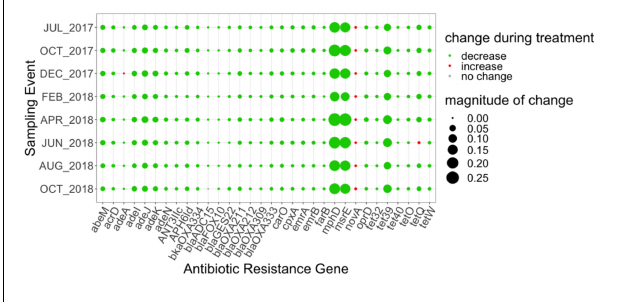
FIGURE 4 | Magnitude of change (based on absolute difference) in relative abundance between influent and secondary effluent of ARGs ( n = 32) detected in the discriminatory resistome (ARGs which most effectively distinguish the influent versus the secondary effluent) as determined by ExtrARG (Gupta et al., 2019). Change was calculated as the difference between the relative abundance of the secondary effluent and the relative abundance of the